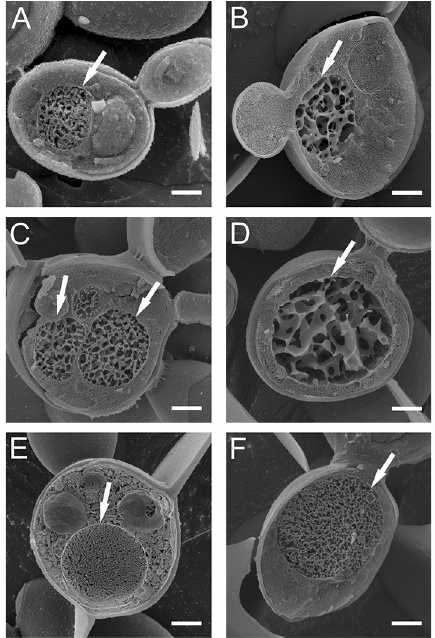
Figure 4. Cryo-SEM image of: ( A ) a control C. albicans cell; ( B – F ) C. albicans cells after incubation with AAF (100 µg mL −1 ); ( B ) a magnified cell with a proportionally enlarged nucleus, ( C ) a cell with three porous structures—two nuclei and a nucleolus, ( D ) a cell with a very large nucleus. E and F show cells with a clearly enlarged nucleus in comparison to the control. Bars represent 2